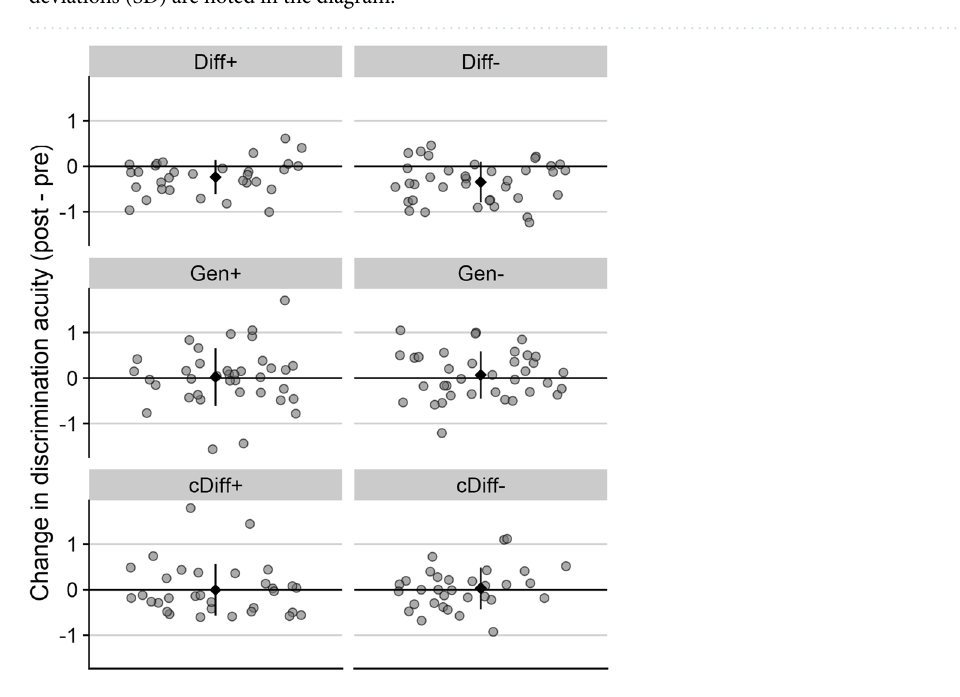
Figure 4. Individual change scores in discrimination acuity (post–pre standard deviation) per group. Positive/ negative values indicate impaired/improved discrimination acuity, respectively. Black diamonds depict mean scores, while error bars represent aggregated standard